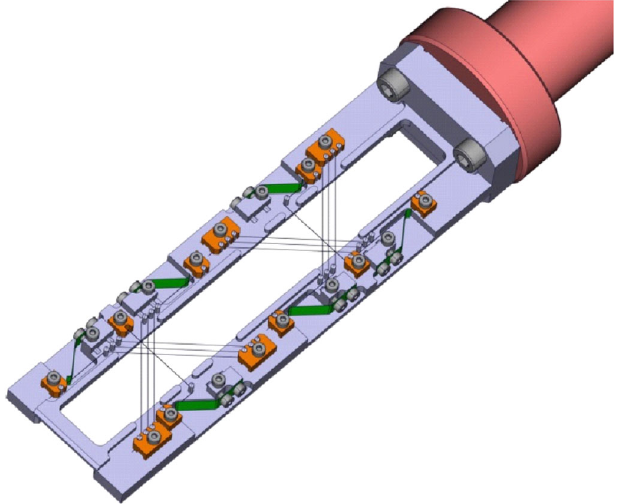
FIG. 2. Technical drawing of the SwissFEL wire-fork. Thanks to a system of multiple pin slots, the vertex of each wire-triplet can be set at three different distances (8,5.5 and 3 mm) from the center of the vacuum chamber. In order to outline such a flexibility feature of the design of the SwissFEL wire-fork — in the present technical drawing — all the three pin slots are shown to be provided with horizontal and vertical wires. In reality, only one of the three possible pin slots will be equipped with a wire so that each of the two wire triplets of the SwissFEL wire-fork will be composed of: one single horizontal wire; one single vertical wire; one single wire for XY